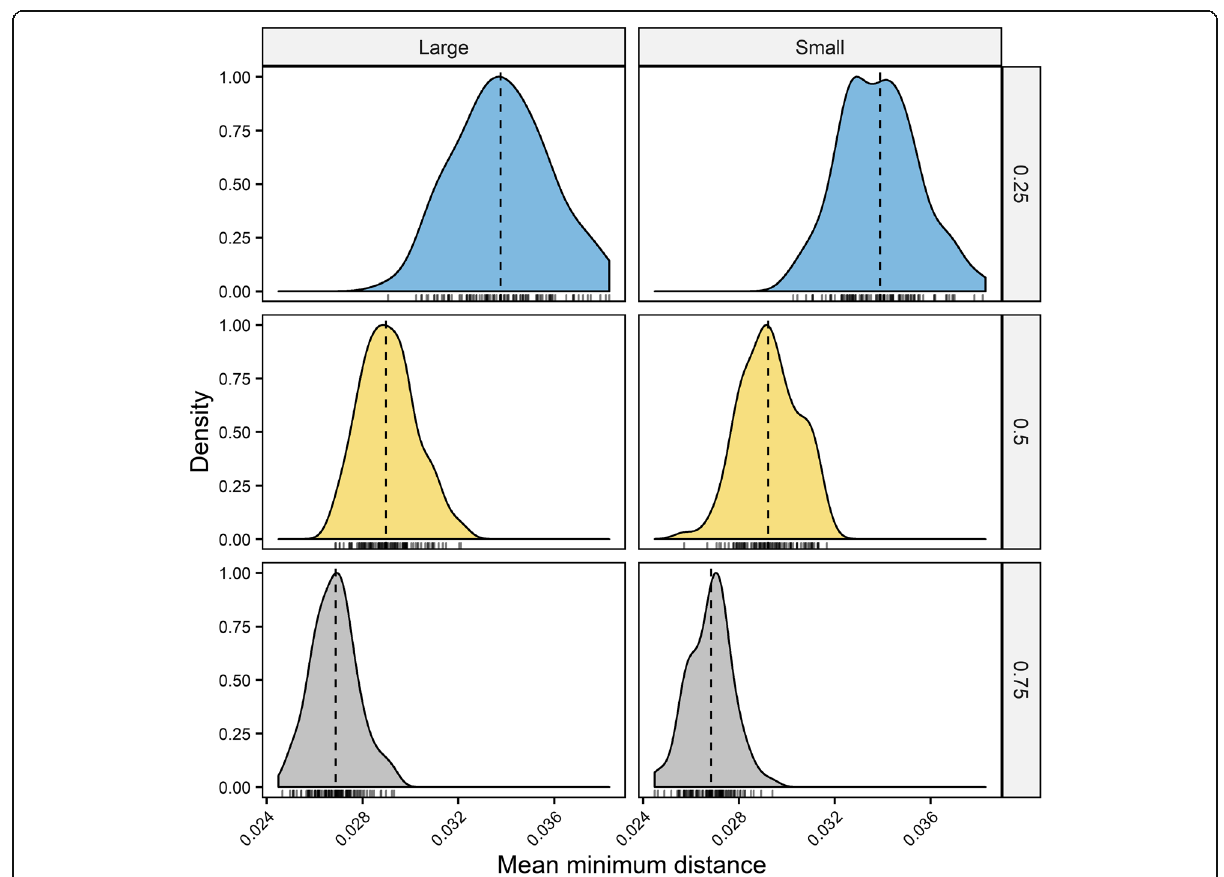
Fig. 3 The density of the mean distance between a single pathogen propagule and its nearest BCA propagule in a given simulation run for each combination of heterogeneity grain size and patchiness for randomly (Poisson) distributed pathogens and BCAs. The dashed line indicates the median